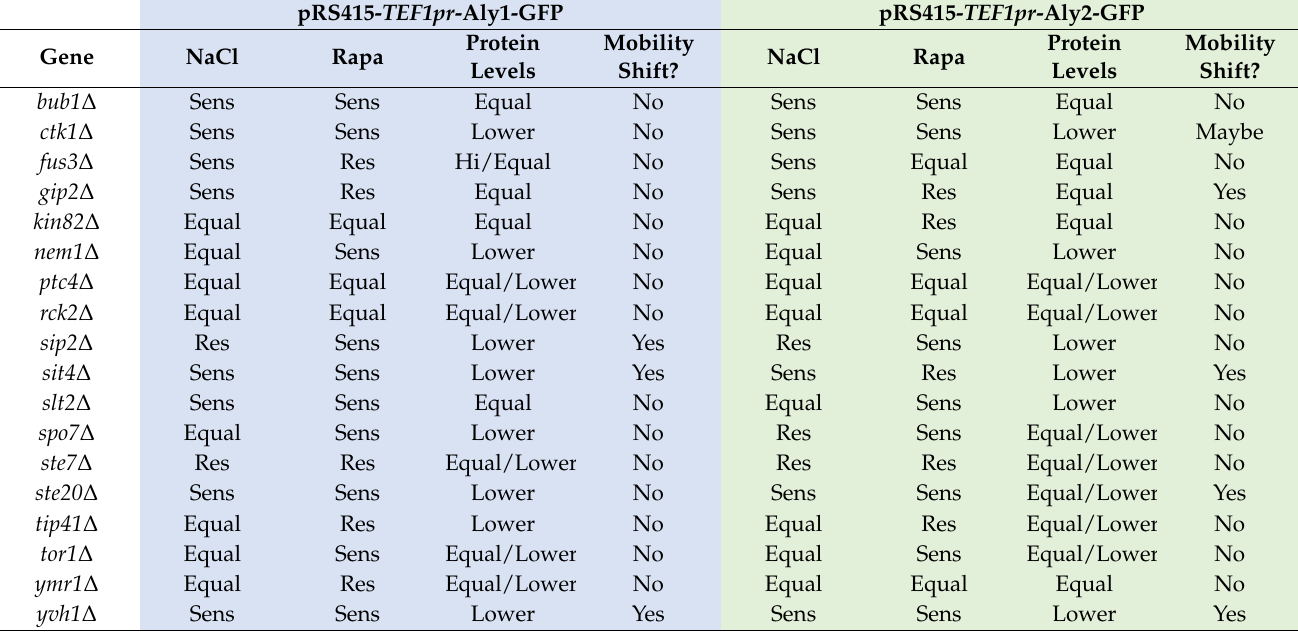
Table 1. Summary of screening 18 gene deletion candidates from KinDel library with over-expression of Aly1 or